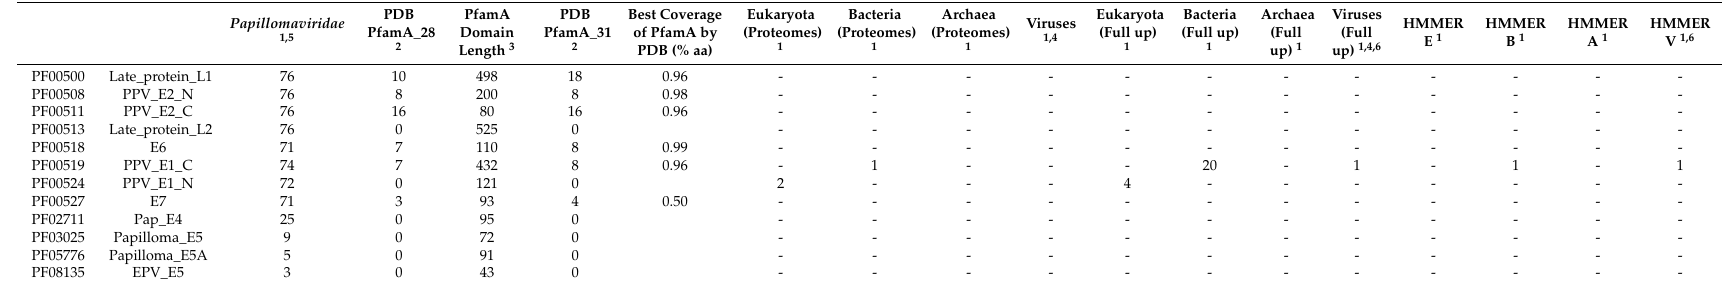
Table 2. PV_PfamA domain occurrence in